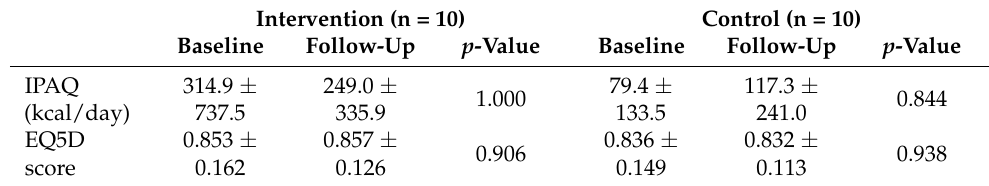
Table 4. Comparison of IPAQ and HRQOL at baseline and 6 months after exercise intervention. Intervention (n = 10) Control (n = 10) Baseline Follow-Up p -Value Baseline Follow-Up p